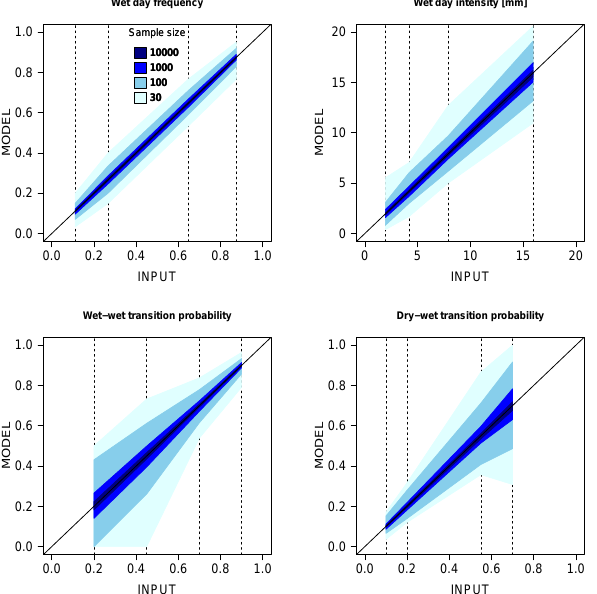
Figure 2. Reproduction of average wet day frequency (wdf), mean wet day intensity (wdi), wet–wet transition probability ( p 11 ) and dry–wet transition probability ( p 01 ) for the four idealised climate regimes ranging from very dry (left) to very wet (right) as indicated by dashed lines. The shaded areas correspond to the range between the 2.5 and 97.5% empirical quantiles of 100 realisations. Results are shown for sample sizes of 10000, 1000, 100 and 30 (grey shad-